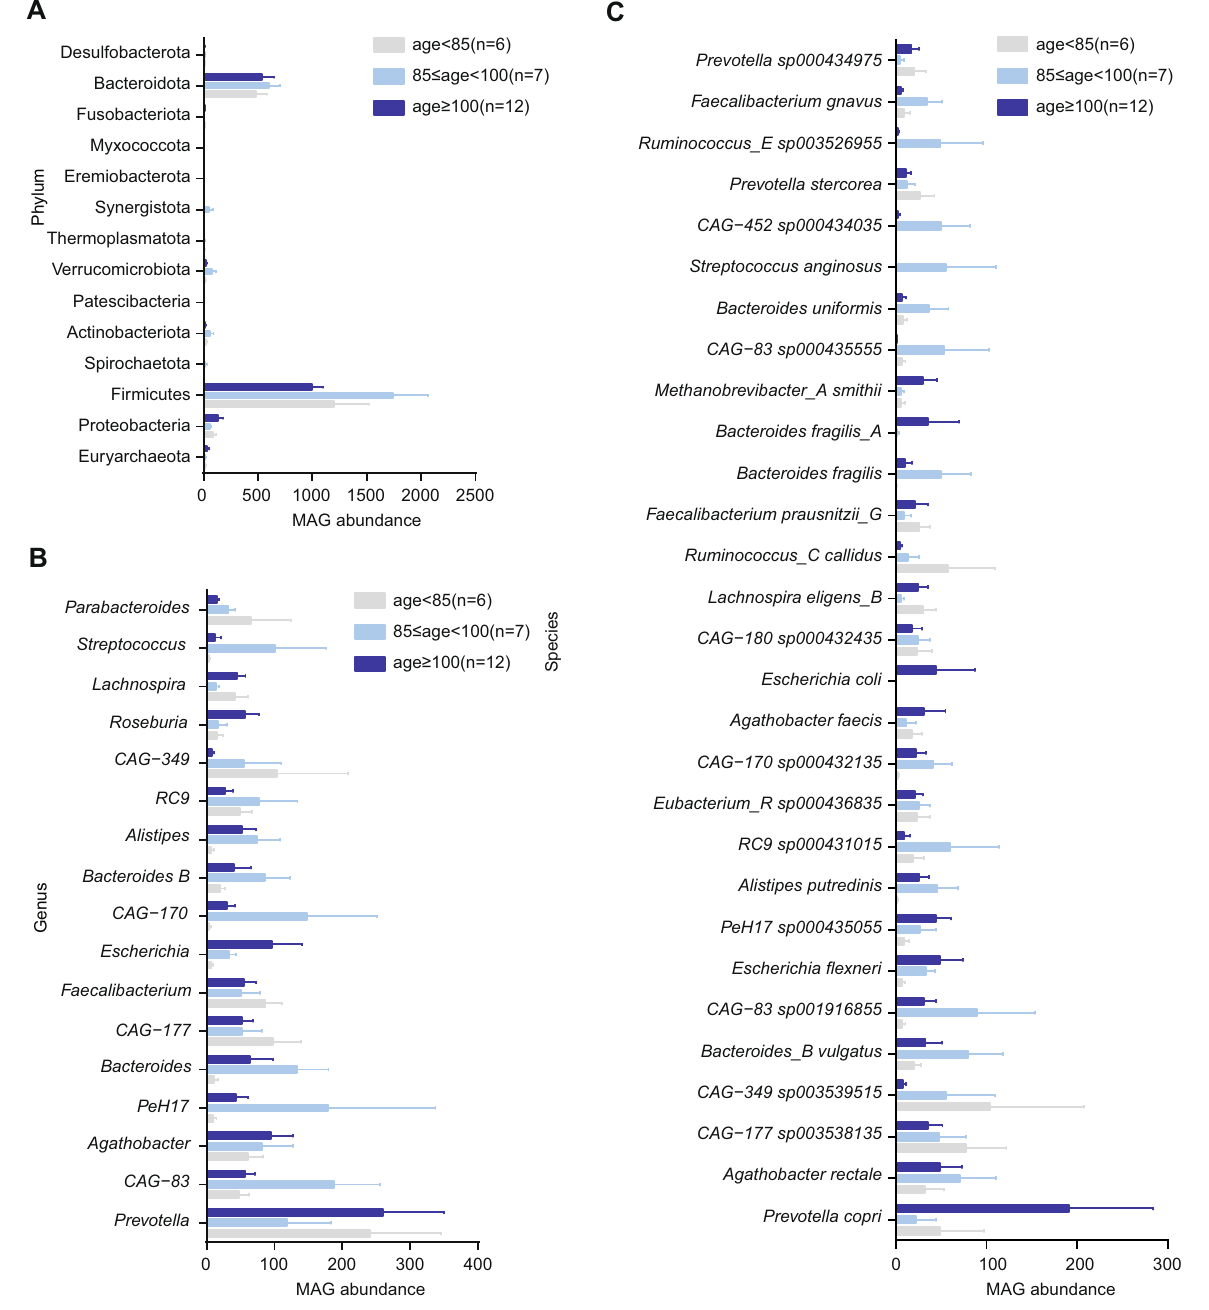
Fig. 3 MAGs abundances at phylum, genus and species levels in different age groups. MAGs abundance at the phylum ( A ), genus ( B ) and species ( C ) levels in subjects with ages of <85 (group1), 85 – 100 (groups), and ≥ 100 (group3) years. The abundance of MAGs was calculated by metaWRAP. All taxa showed no signi fi cance among